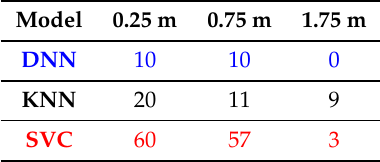
Figure 15. Model comparison: δ 2 vs. KNN vs. SVC. Table 5. Misclassification count for each